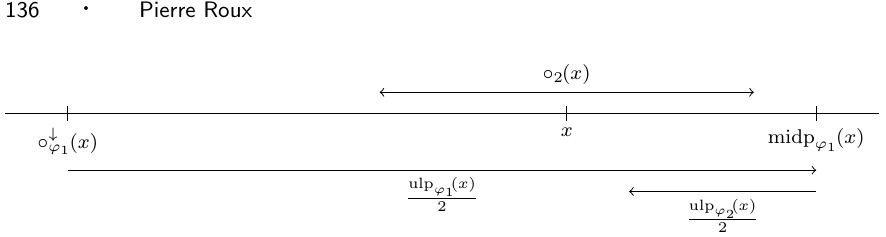
Fig. 2: Illustration of Lemma 16. Since x is below midp ϕ midp ϕ ( x ) − ulp ϕ ( x ) / 2 then ◦ 2 ( x ) is also below midp ϕ 1 2